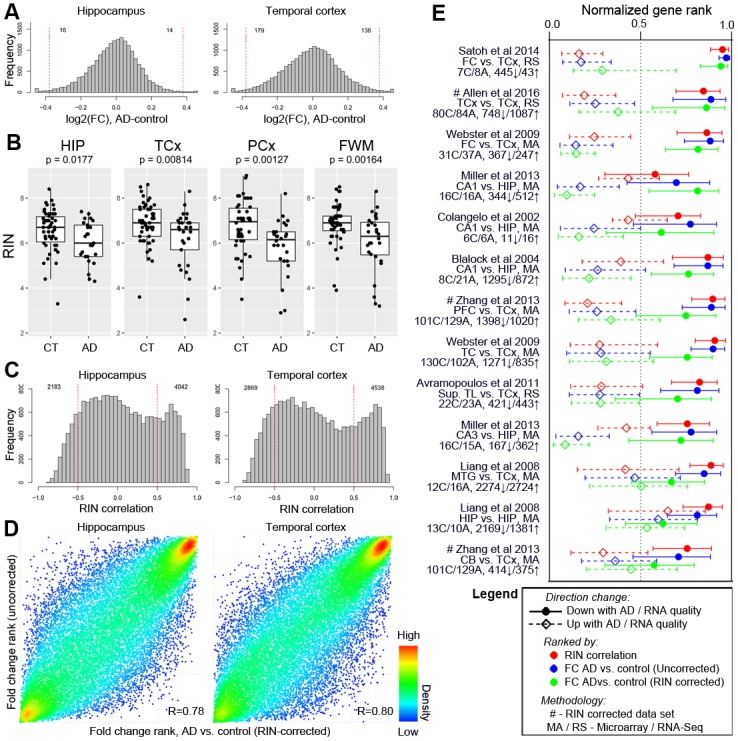
Differences in RNA quality between AD and controls greatly impact gene expression results.See legend for Figure 6 - all panels are matched, but only when considering the subset of dementia donors with AD diagnosis. Panel C is identical to Figure 6C and reproduced for continuity.